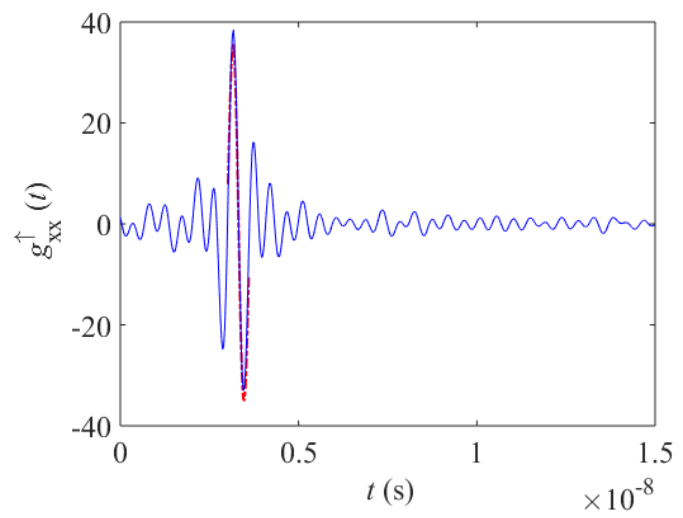
Figure 9. Measured (solid blue line) and modelled (dash-dotted red line) radar Green’s function ( g ↑ xx ) in the time (t)-domain.